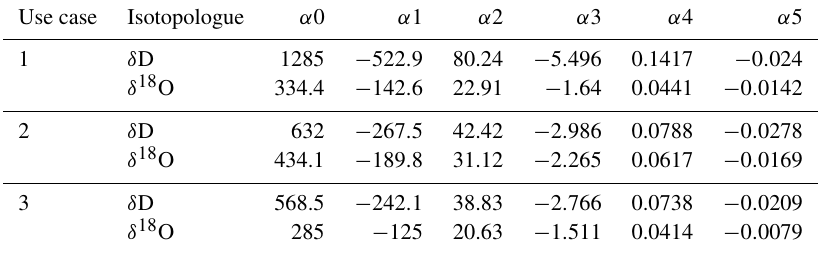
Table D1. Parameter values to use with Eq. (6) to obtain standard errors in WIA1 isotope ratios, if more detailed error estimations than those given in Table 4a are desired. The three use cases are described in the main